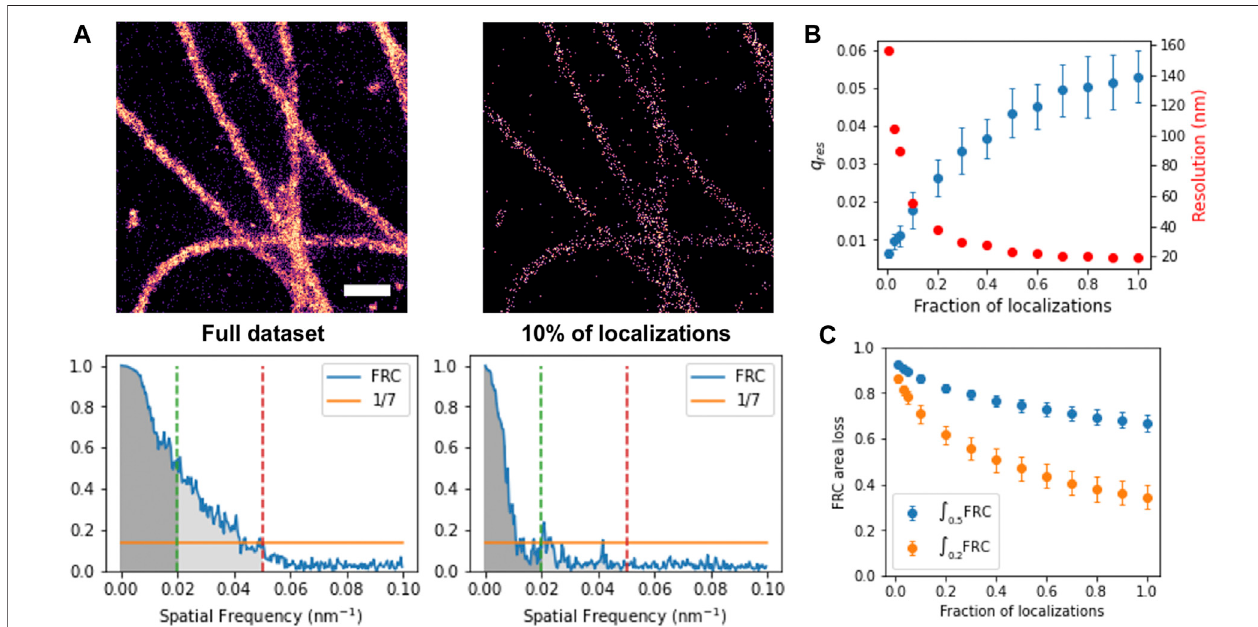
FIGURE2| FourierRingCorrelationtoestimateimageimprovement withincreasingdensity oflocalizations. (A) Histogramrendering(top)and correspondingFRC (bottom) of full and sparse set of localizations, with threshold 1/7 and area threshold 0.2 (green) and 0.5 (red) indicated. Scale bar: 300 nm, (B) FRC cutoff frequency (blue) and corresponding resolution (red) as function of the fraction of total localizations, (C) FRC area loss for a threshold of 0.2 (yellow) and 0.5 (blue) as function of the fraction of total